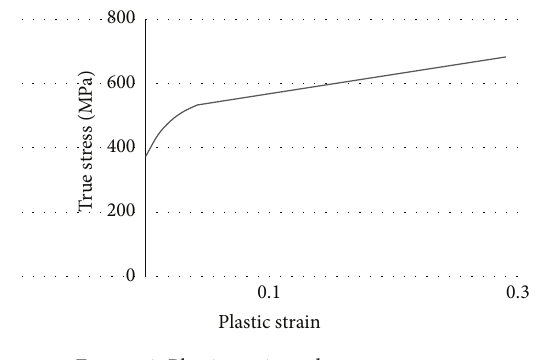
Figure 1: Structure of steering parts.